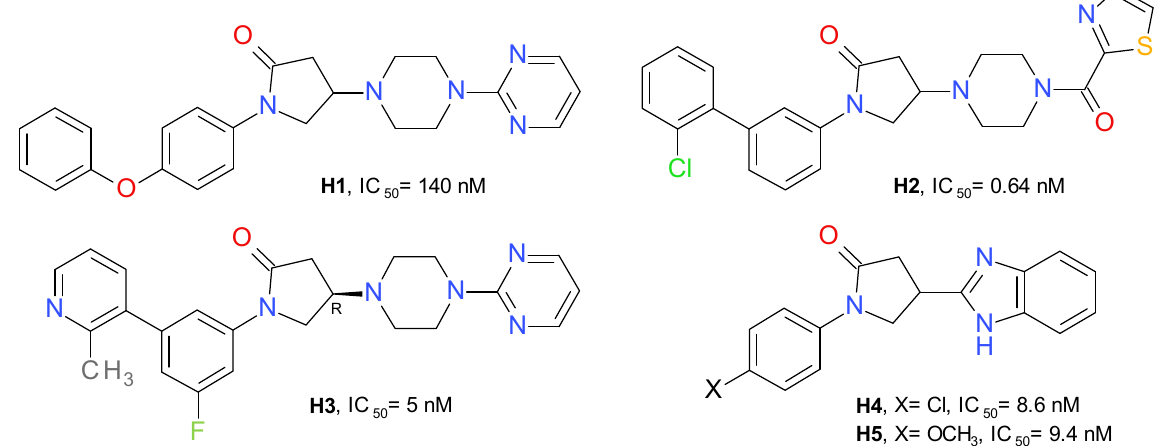
Figure 10. Reversible MAGL inhibitors—pyrrolidone derivatives.